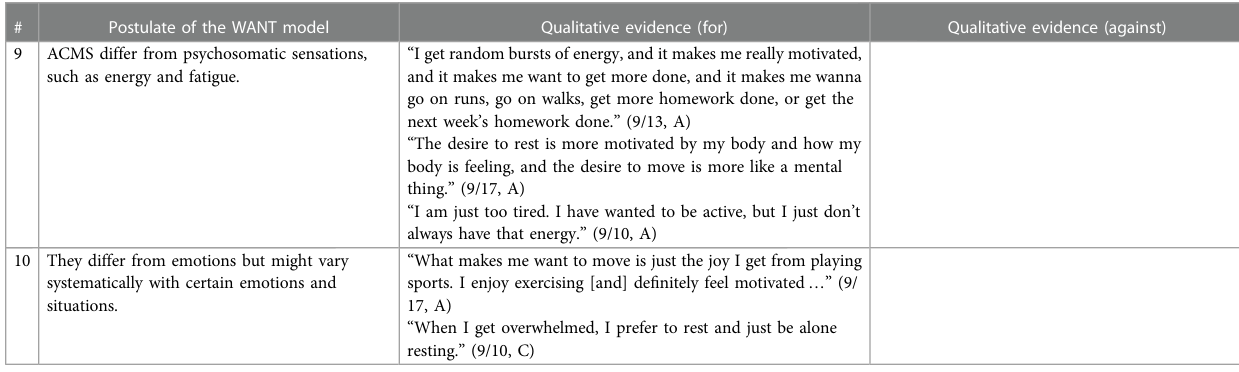
TABLE 5 Qualitative evidence that affectively-charged motivation states (ACMS) have in fl uence on movement and sedentary behaviors. Qualitative evidence (for) Movement/physical